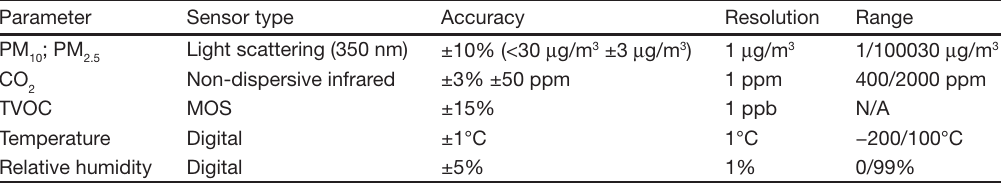
Table 2. IAQ monitoring